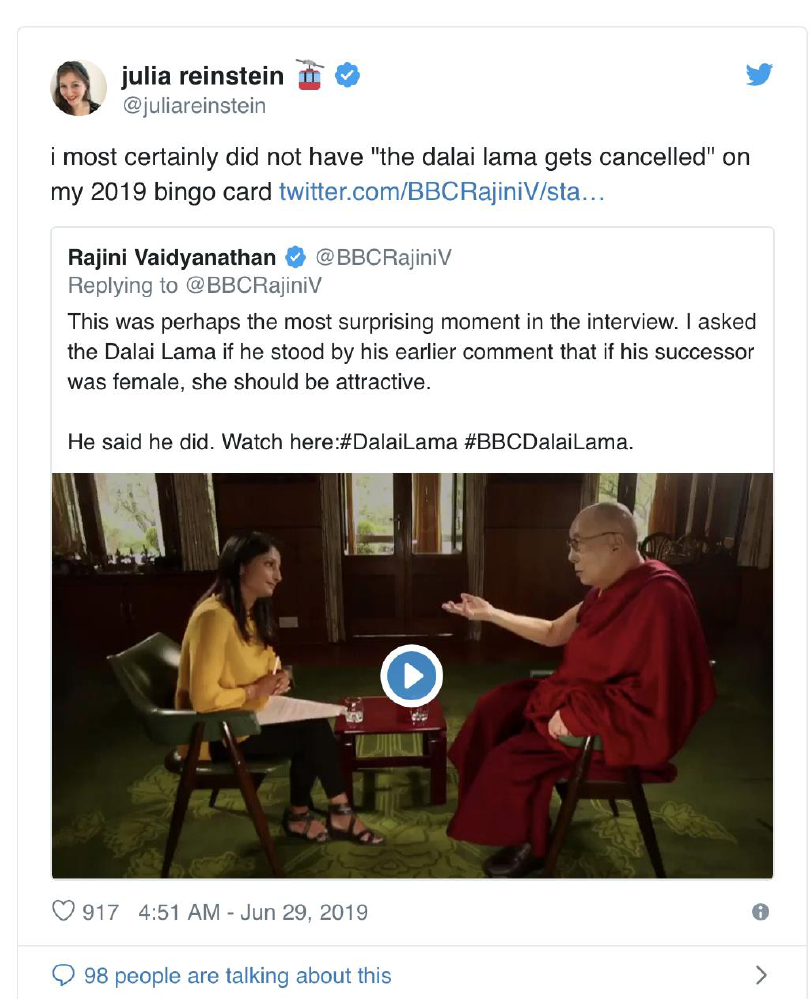
Figure 1 : BuzzFeed reporter Julia Reinstein ’ s retweet of a BBC news interview between Rajini Vaidyanathan and the Dalai Lama, with the commentary, “ i most certainly did not have ‘ the dalai lama gets cancelled ’ on my 2019 bingo card